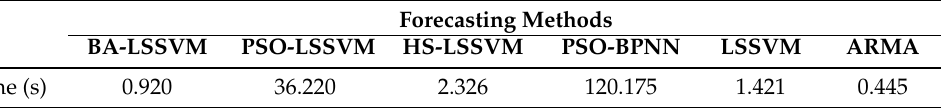
Table 7. The time durations of the computing about different approaches.